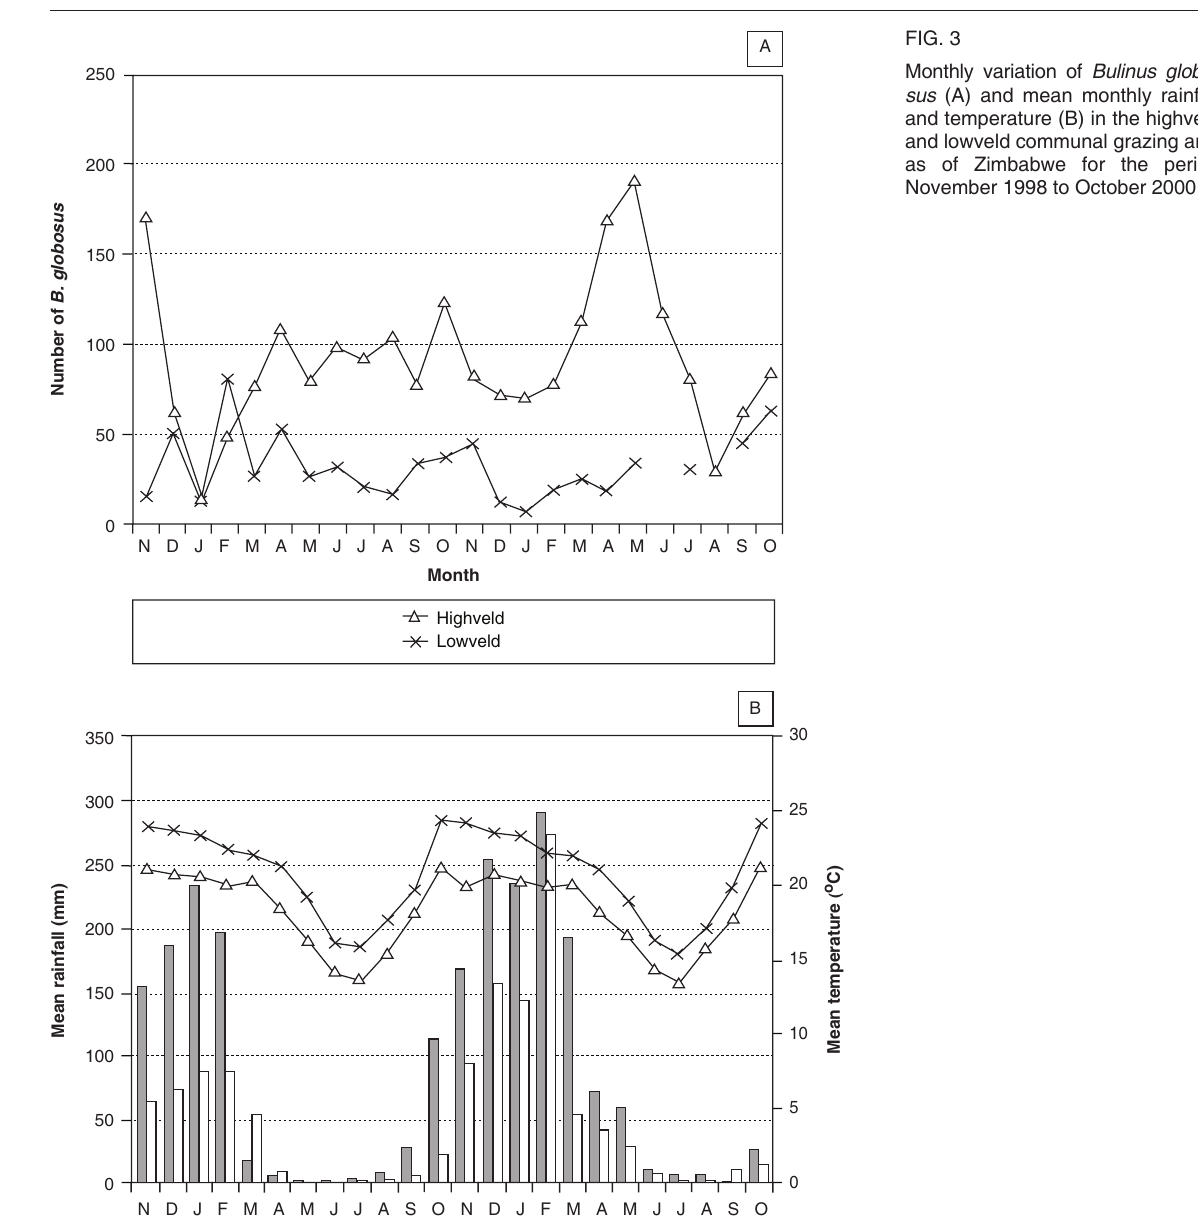
FIG. 3 Monthly variation of Bulinus globo- sus (A) and mean monthly rainfall and temperature (B) in the highveld and lowveld communal grazing are- as of Zimbabwe for the period November 1998 to October